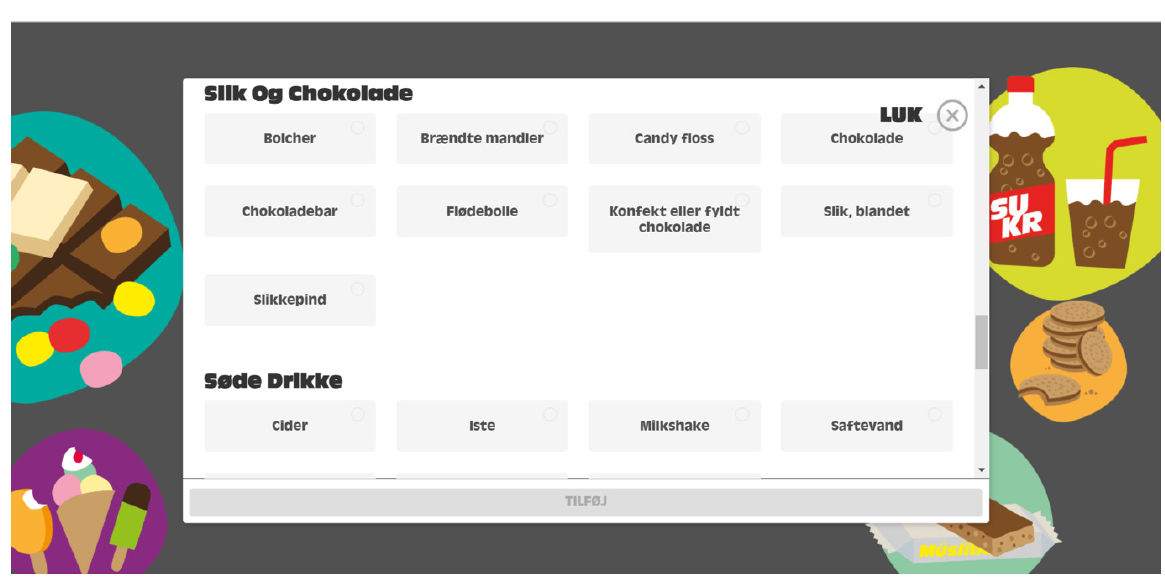
Figure A1. Screen shot from the SRFS. Website where parents registered which discretionary foods and drinks their child had eaten at specific occasions. On this picture is “Candy and chocolate” and “Sweet drinks”.